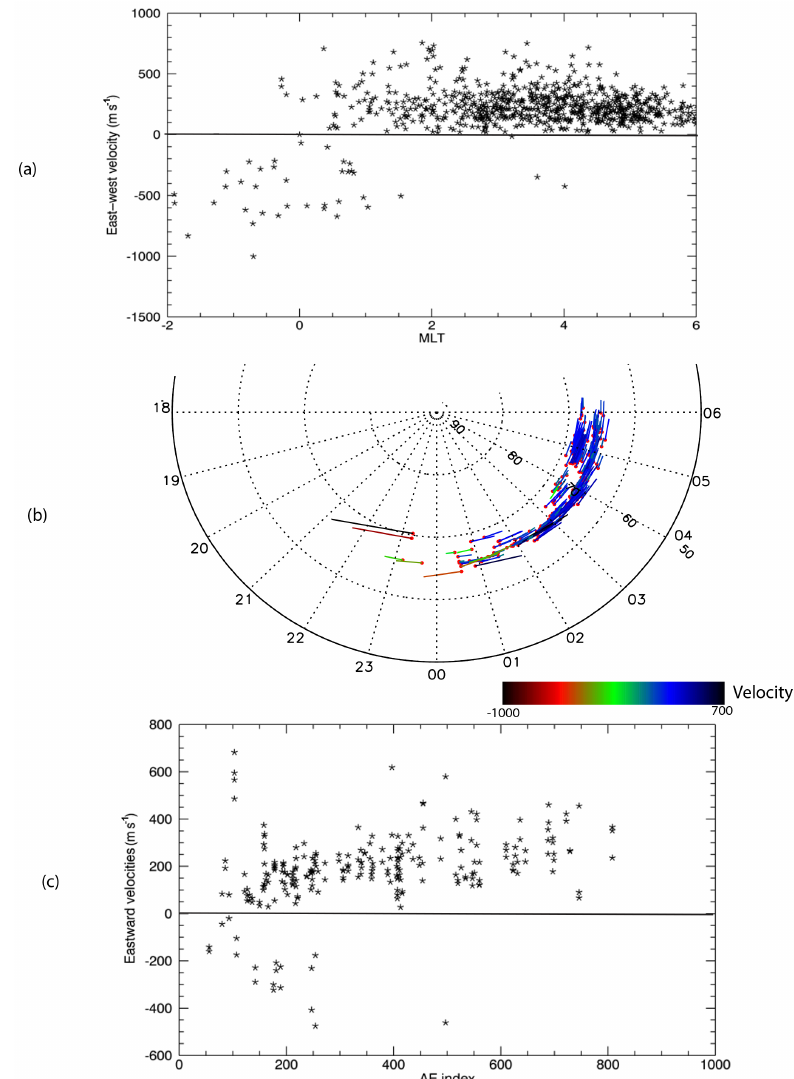
Figure 3. (a) Distribution of the patches’ azimuthal velocities. The horizontal axis is the magnetic local time. The vertical axis is the eastward velocity in ms − 1 . (b) Map of velocities of all the patches in the magnetic local time and magnetic latitude. (c) Distribution of patch velocities with respect to AE